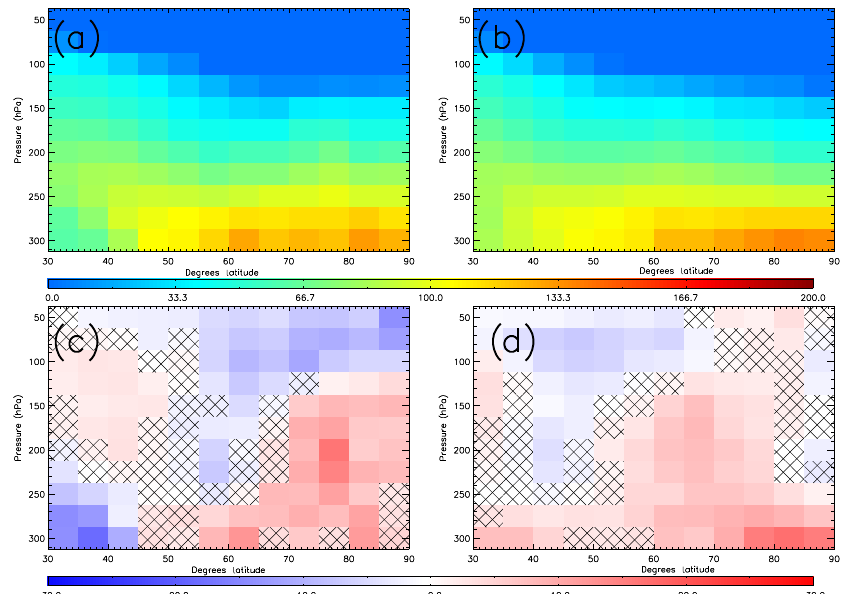
Figure 4. MIPAS PAN (pptv), 2002–2012, zonally averaged (90 ◦ W to 20 ◦ E) for (a) the wintertime (NDJF) NAO positive phase, (b) the wintertime NAO negative phase, (c) the positive NAO phase anomaly relative to the wintertime average and (d) the negative NAO phase anomaly relative to the wintertime average. Black hatched regions highlight insignificant differences at the 95% confidence level based on the